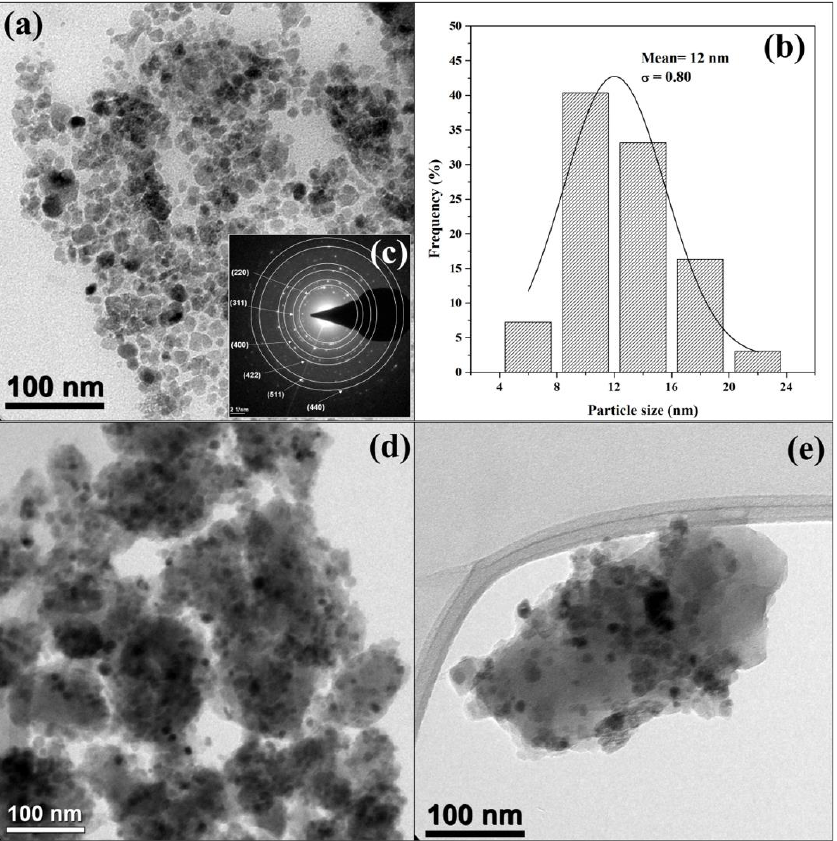
Figure 7. TEM image ( a ), particle size histogram ( b ), and SAED pattern ( c ) of Fe 3 O 4 nanoparticles, TEM image of MNPsFe 3 O 4 -SiO 2 ( d ) and MNPsFe 3 O 4 -SiO 2 -poly (NVCL-co-MAA) nanocomposite ( e ). The LCST of the MPNsFe 3 O 4 -SiO 2 -poly(NVCL-co-MAA) nanocomposite was meas-